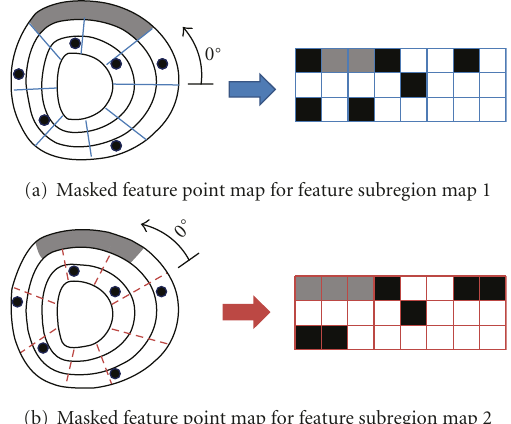
Figure 2: Masked Feature Point Map. (Note that these images are for illustration only and do not show the full 720 bins used.) White regions do not contain any feature points. Black regions have one feature point each. The gray regions are noisy regions that should not be used in